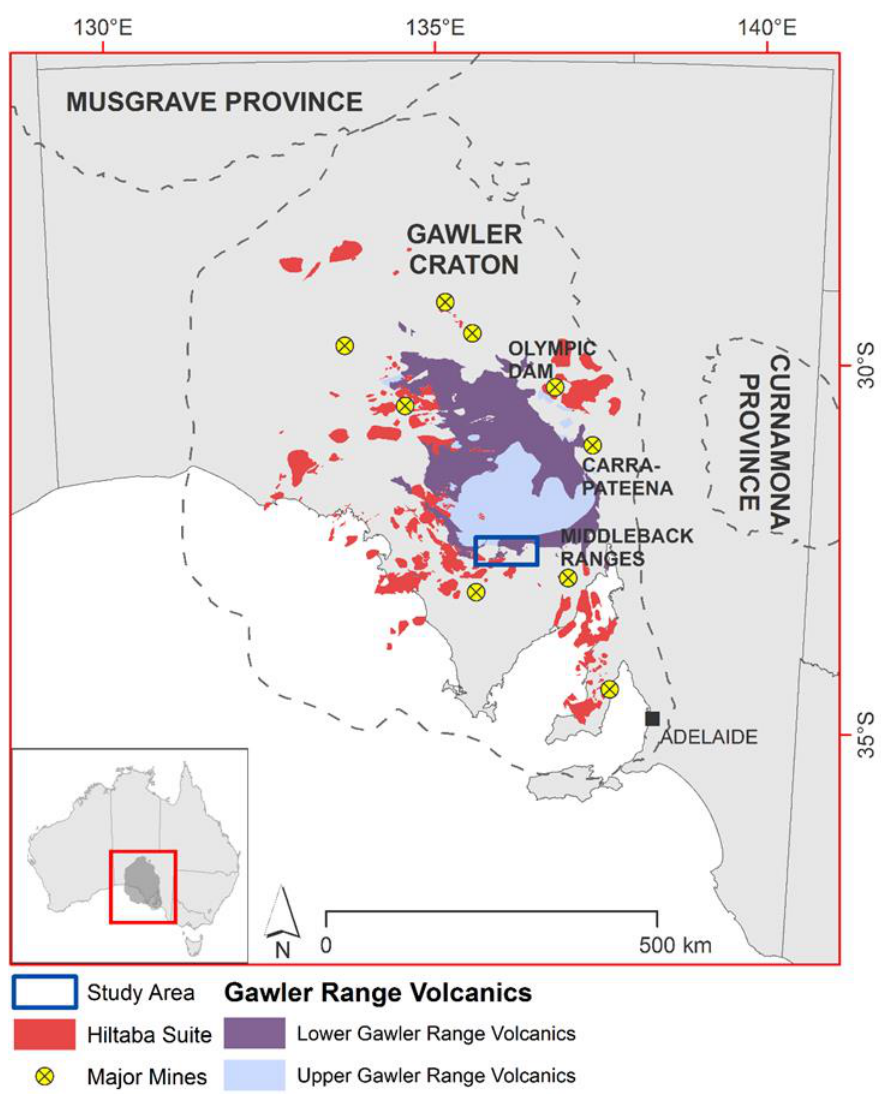
Figure 1. Simplified geological map showing the location of the study area and other known major deposits throughout the Gawler Craton. The dark grey area in inset map corresponds to the extent of the Gawler Craton. Modified after Forbes, et al . [43].